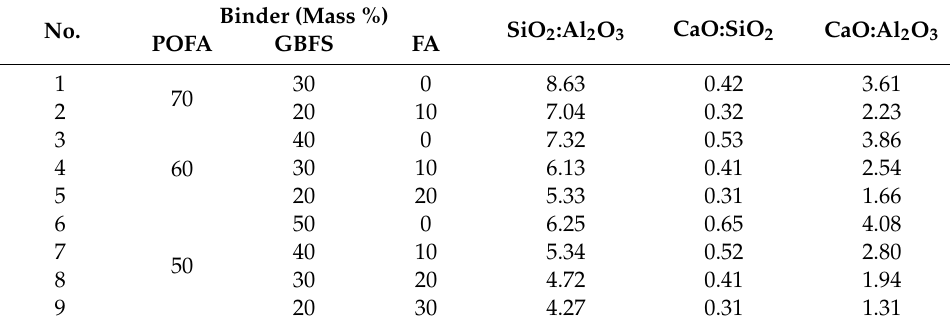
Table 3. Contents of constituents in high volume POFA mix